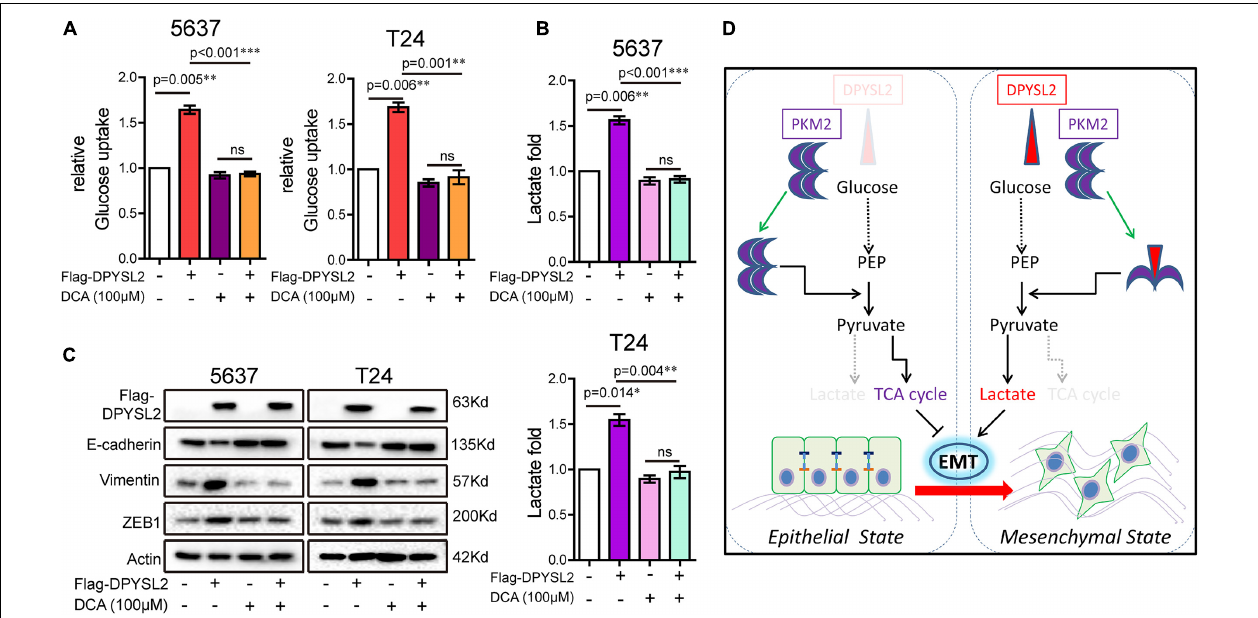
FIGURE 7 | Glycolysis inhibitor dichloroacetate (DCA) abolished DPYSL2-induced aerobic glycolysis and EMT marker alterations in bladder cancer cells. (A–C) 5637 or T24 cells were transfected with Flag-DPYSL2 and incubated for 12 h, followed by DCA (100 µ M) treatment for 36 h. Glucose uptake (A) , lactate production (B) , and protein levels of EMT markers (C) were measured. (D) A schematic diagram illustrates that DPYSL2 promotes EMT and aerobic glycolysis by interacting with PKM2. * P < 0.05, ** P < 0.01, *** P < 0.001; ns,